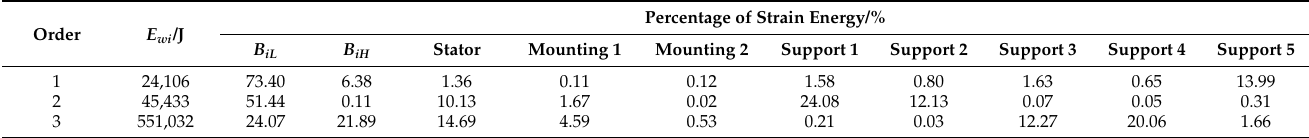
Table 6. Strain energy distribution at each